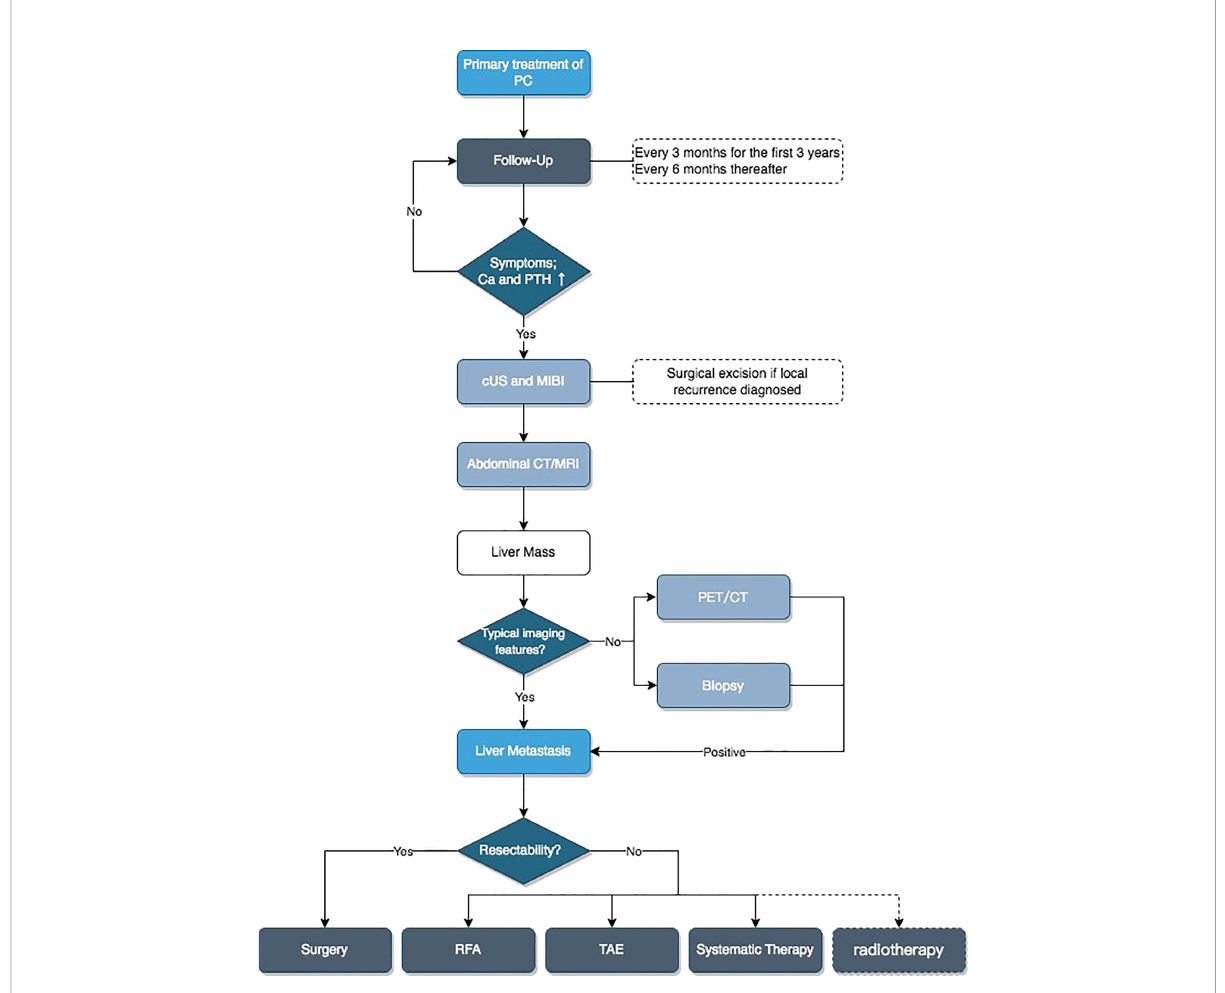
FIGURE 7 Flowchart for diagnosis and treatment of liver metastatic patients. Ca, serum calcium; PTH, parathyroid hormone; cUS, cervical ultrasound; MIBI, 99m Tc-MIBI scan; CT/MRI, contrast-enhanced CT and/or MRI; PET/CT, [18F]FDG-PET-CT or [18F]FCH-PET-CT or [11C]choline-PET-CT; RFA, radiofrequency ablation; TAE, transcatheter arterial embolization; Systematic Therapy, including physiological saline, diuretics, calcitonin, bisphosphonates, cinacalcet, or